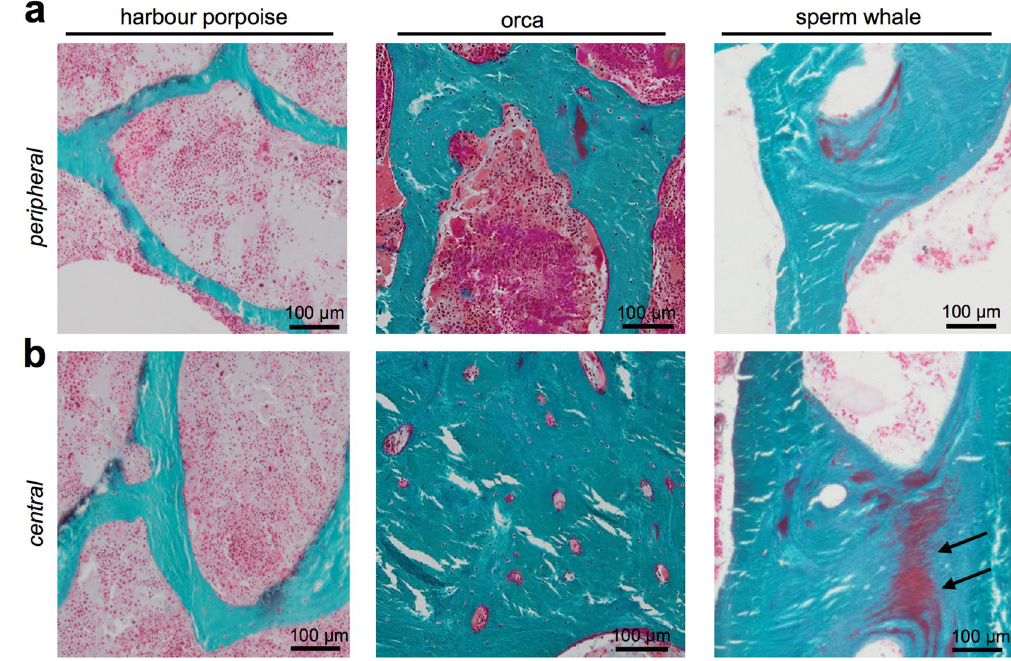
Figure 3. Histology of the vertebral bodies. ( a ) In peripheral zones, the trabeculae were thinner and more separated. ( b ) In the centre of the vertebral body of orcas and sperm whales, the trabeculae converged to a dense structure with a compact appearance that included osteonal structures (Masson Goldner staining, 50x magnification). Harbour porpoise vertebral bone did not show this